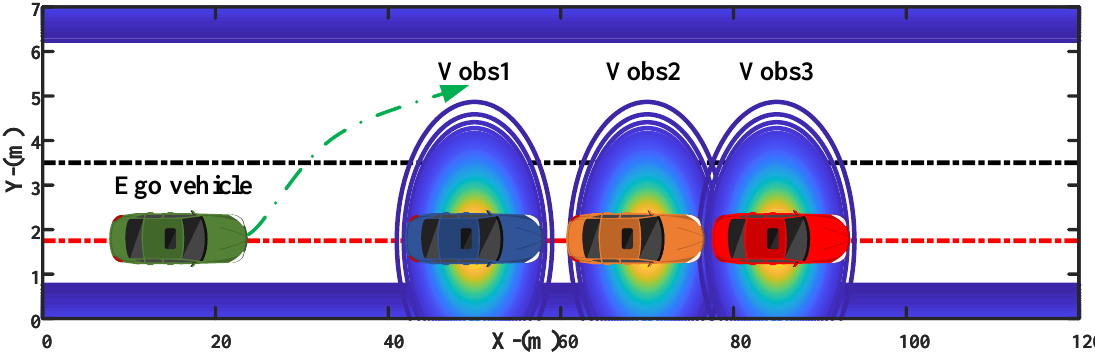
Figure 13. Leading vehicles driving with short interval